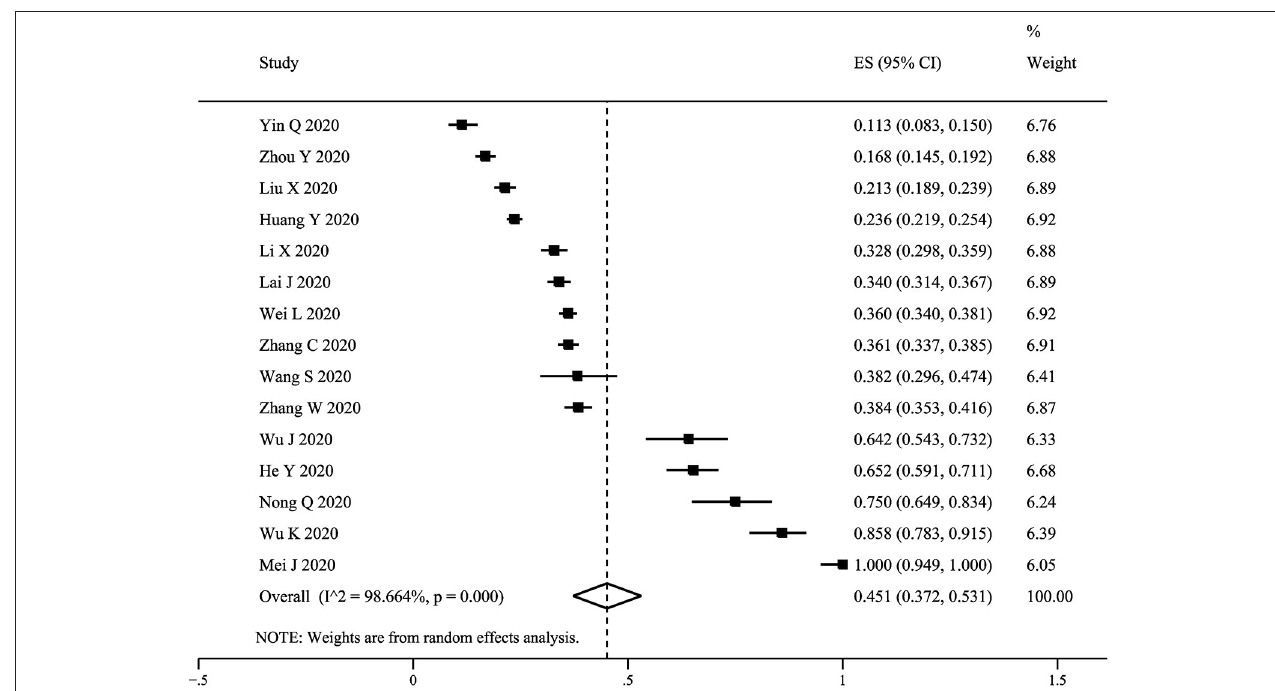
FIGURE 2 | Forest plot of the prevalence of sleep disturbances in Chinese healthcare workers.